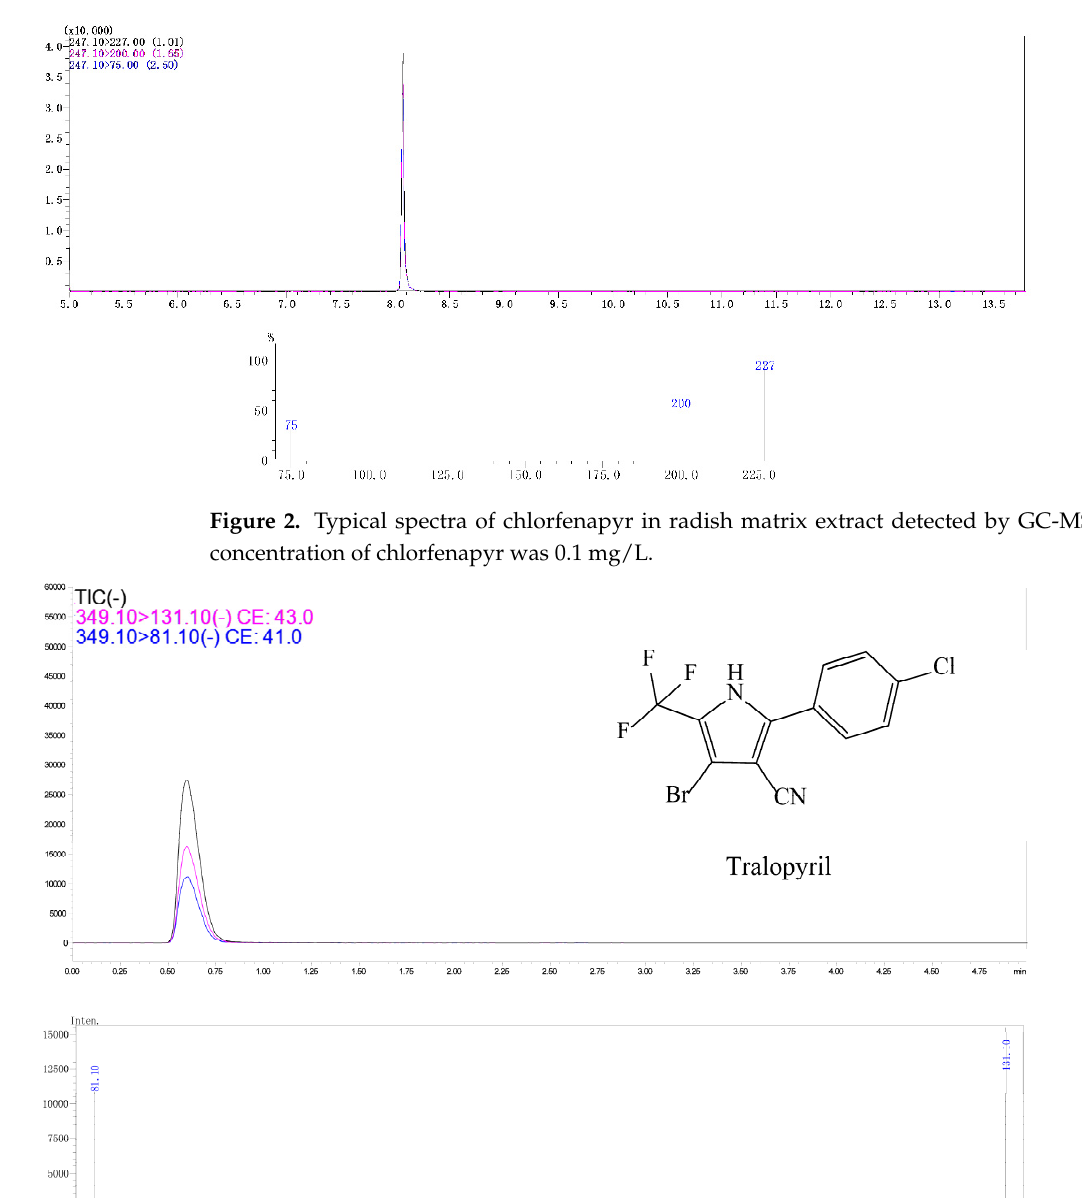
Figure 1. Typical spectra of chlorfenapyr standard in acetonitrile detected by GC-MS/MS. The con- centration of chlorfenapyr was 0.1 mg/L.